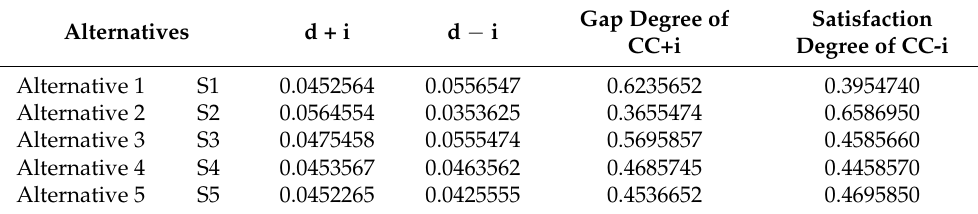
Table 18. Coefficients of closeness to the aspired level throughout the